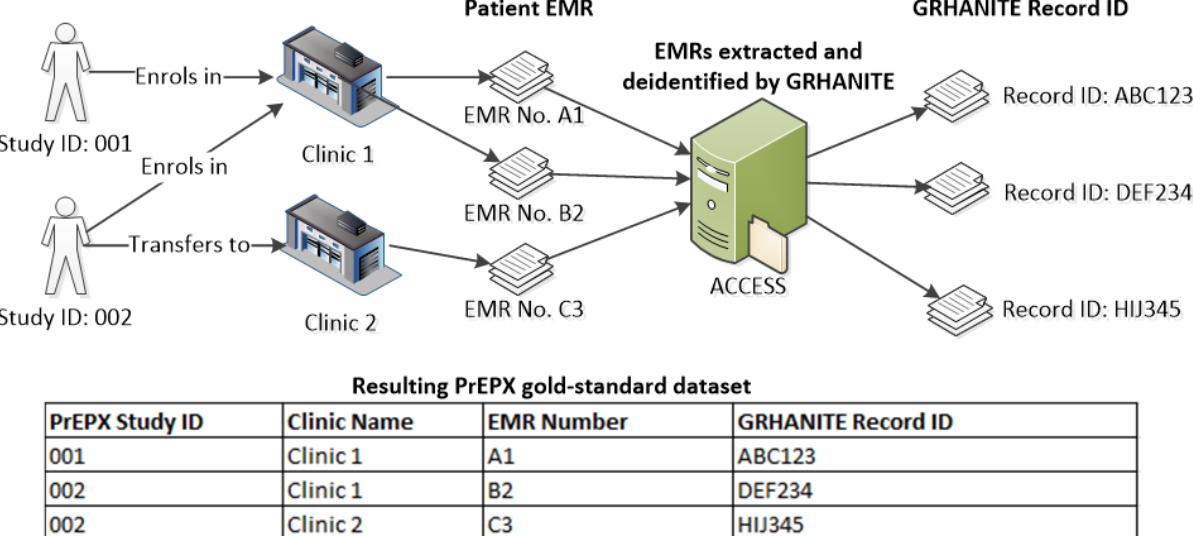
Figure 3. Data flow of electronic medical records in PrEPX and deterministic linkage for the gold-standard